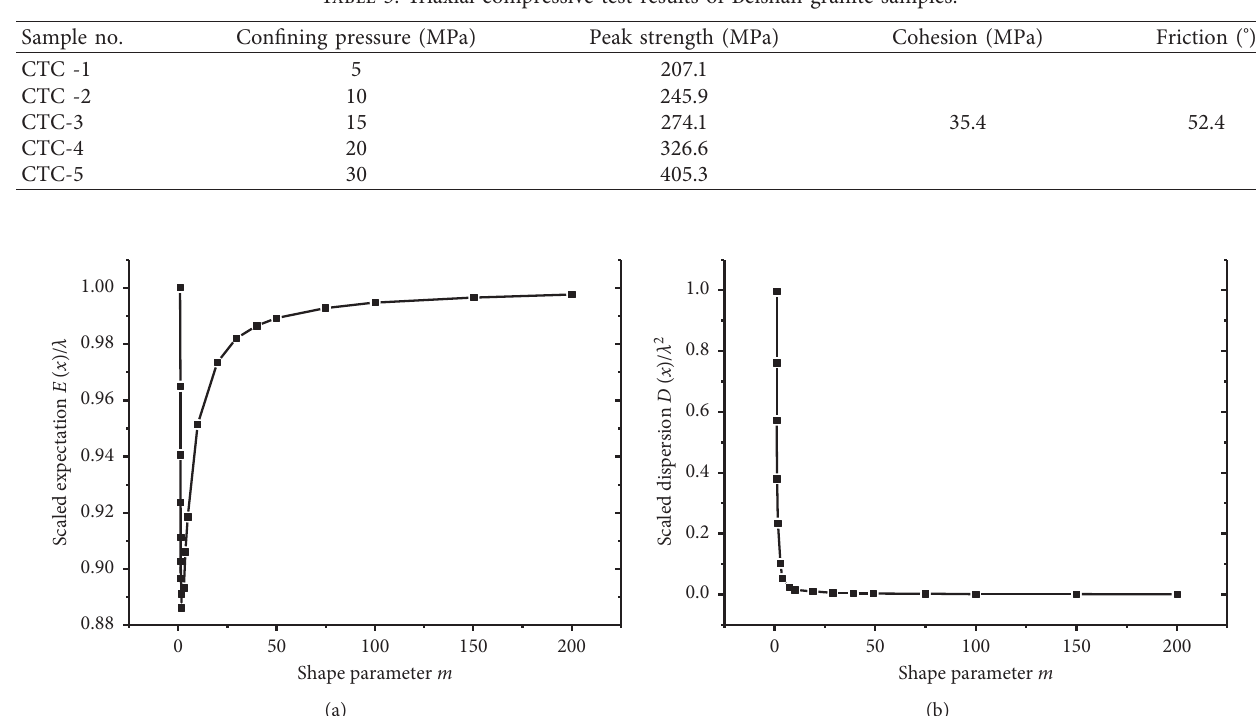
Figure 4: Stress-strain curves and failure patterns under different confining pressures. Table 3: Triaxial compressive test results of Beishan granite samples.